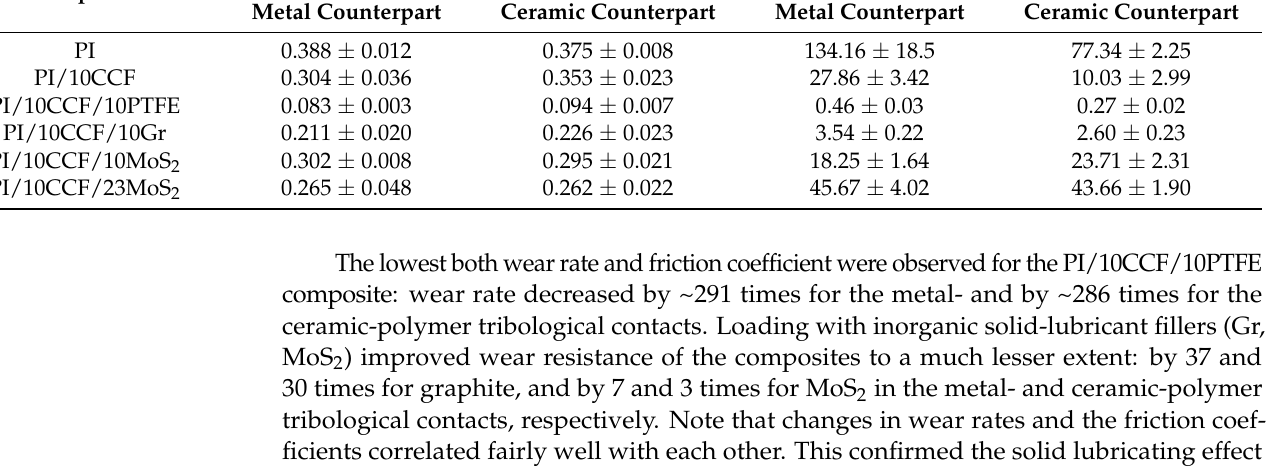
Table 3. The tribological characteristics of the PI-based composites ( P = 5 N; V = 0.3 m/s; the ‘pin-on-disk’ scheme).